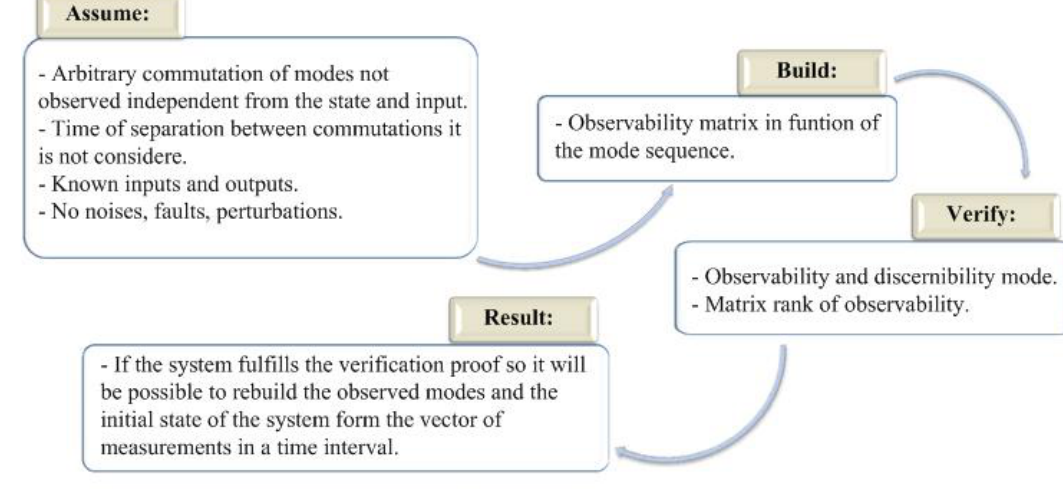
Figure 1. Methodology to prove the observability in piecewise linear